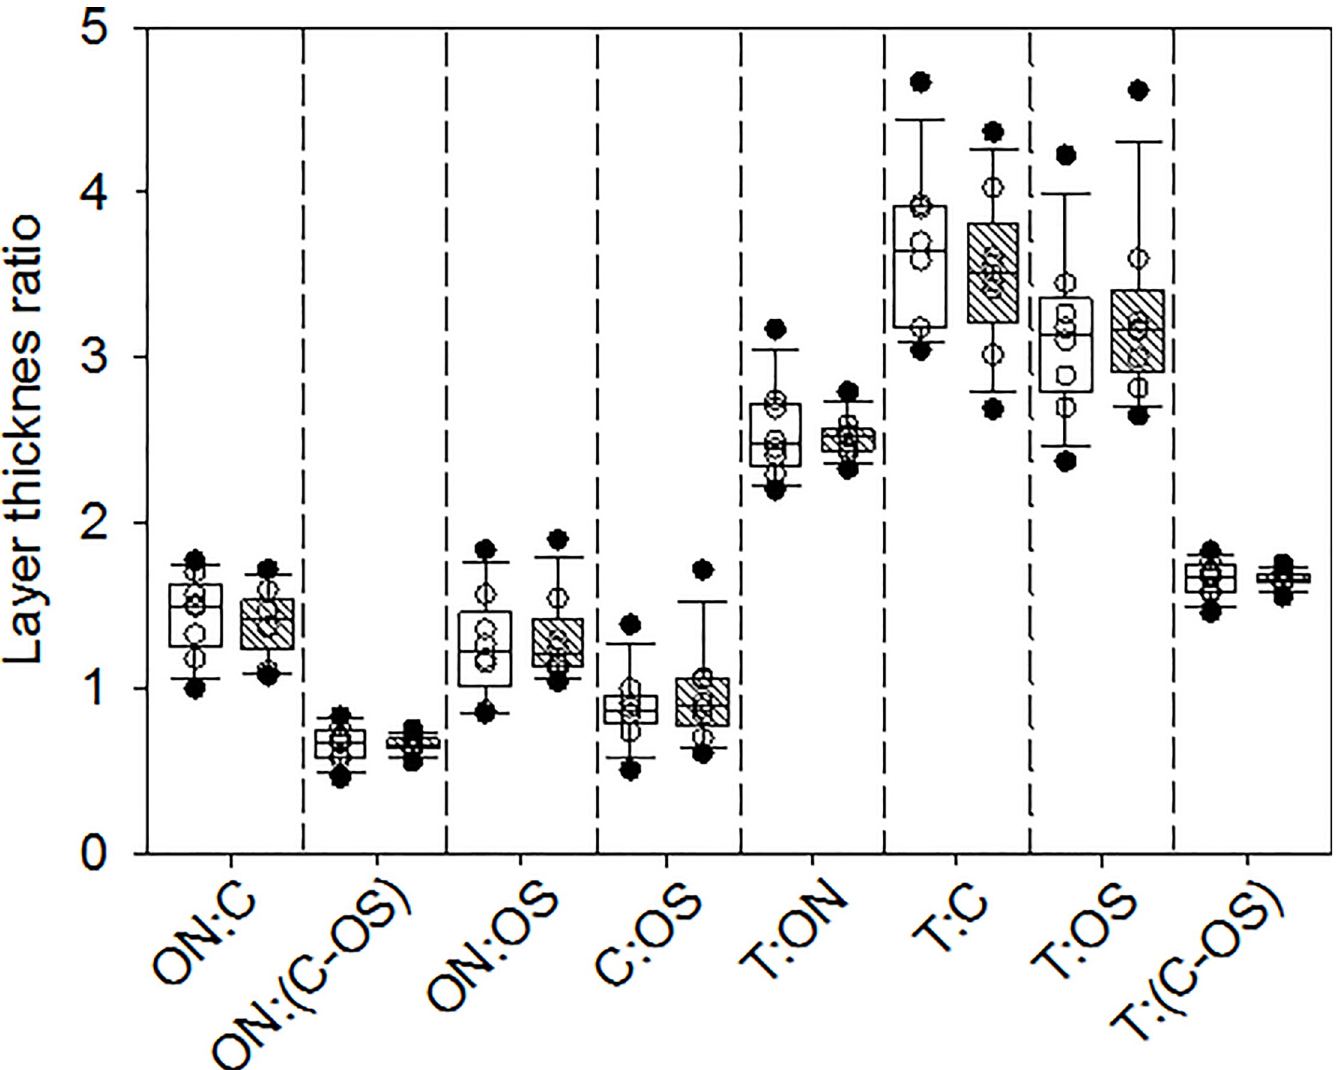
Fig 3. Retinal cell layer thickness ratios in European sea bass fed a 0 or 5% taurine diet (open and cross hatched boxes, respectively). The solid lines within the boxes mark the median values, the boundaries of the boxes the 25 th and 75 th percentiles, and the whiskers (error bars) above and below the boxes the 90 th and 10 th percentiles. Data points between the 90 th and 10 th percentiles are shown as open circles and those outside this interval as filled circles. T = total retina thickness, C = cone photoreceptors layer thickness, ON = outer nuclear layer thickness, OS = thickness of the outer segments of photoreceptor layer, IN = inner nuclear layer thickness ( μ m). Measurements were taken on retinas from eight